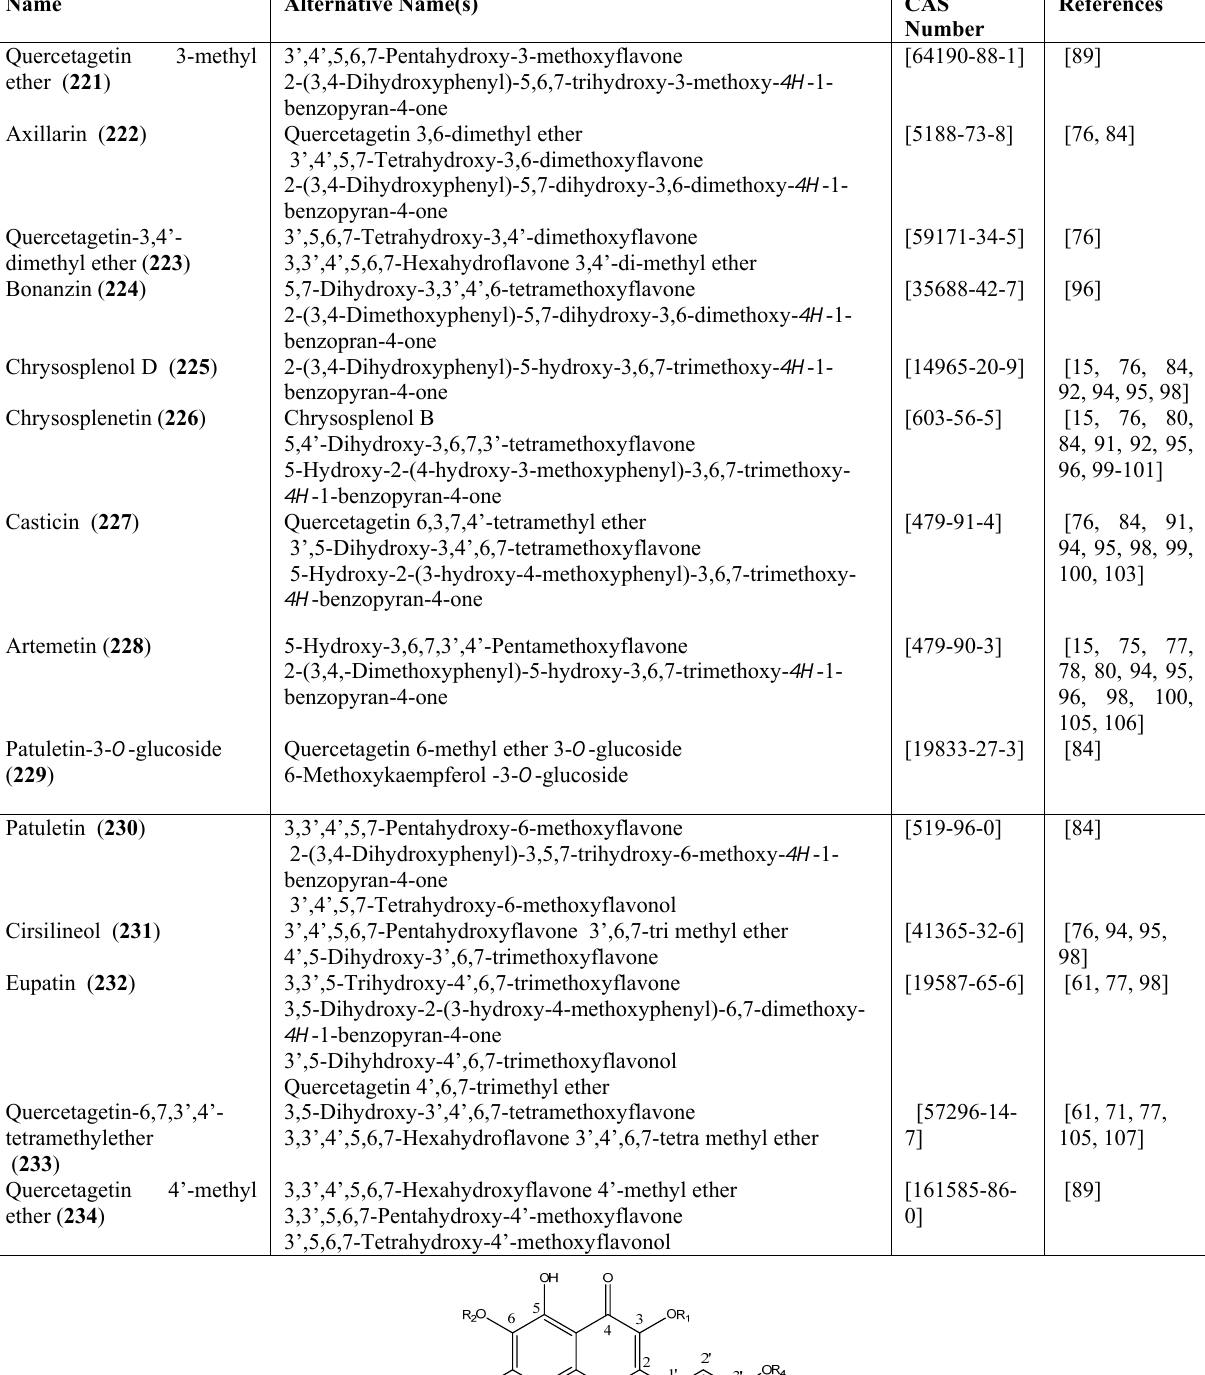
Table 21. Quecetagetin (Hexahydroxy)